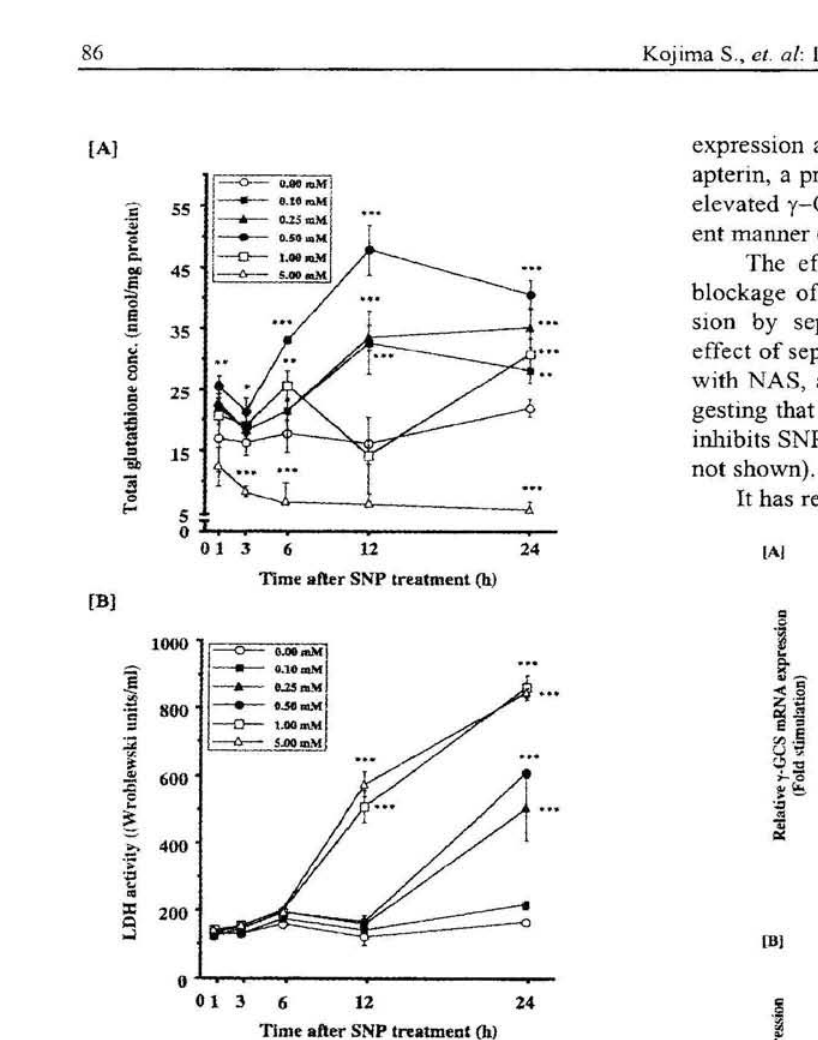
Figure 2. Changes in LDH activity in the medium and total intracellular glutathione (GSH + GSSG) after treatments with various concentrations of sodium nitroprusside (SNP). [A] LDH activity in the medium. The activity was expressed in Wroblewski unit/ml of the medium (Wroblewski unit/ml). [B] Total intracel- lular glutathione (GSH + GSSG) contents. Each point indicates the mean ± SD of 4 wells. ** and *** signif- icantly different from each of the non-treated control groups at p<0.01 and p<0.005, respectively.